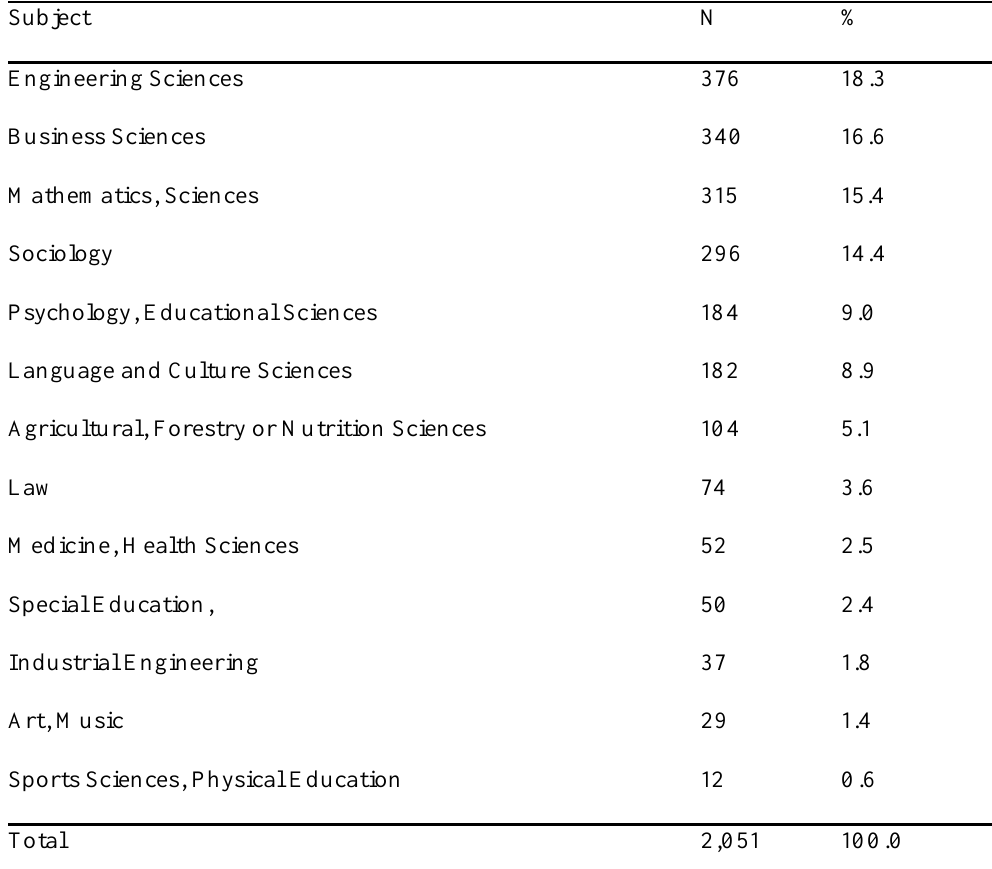
Distribution of Subjects, Major